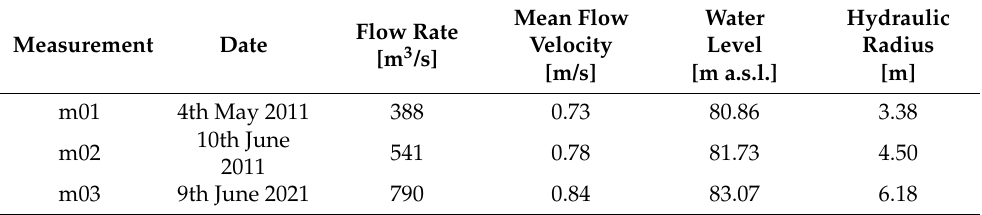
Table 1. Summary of the measured hydraulic and hydrologic parameters from field surveys. Measurement